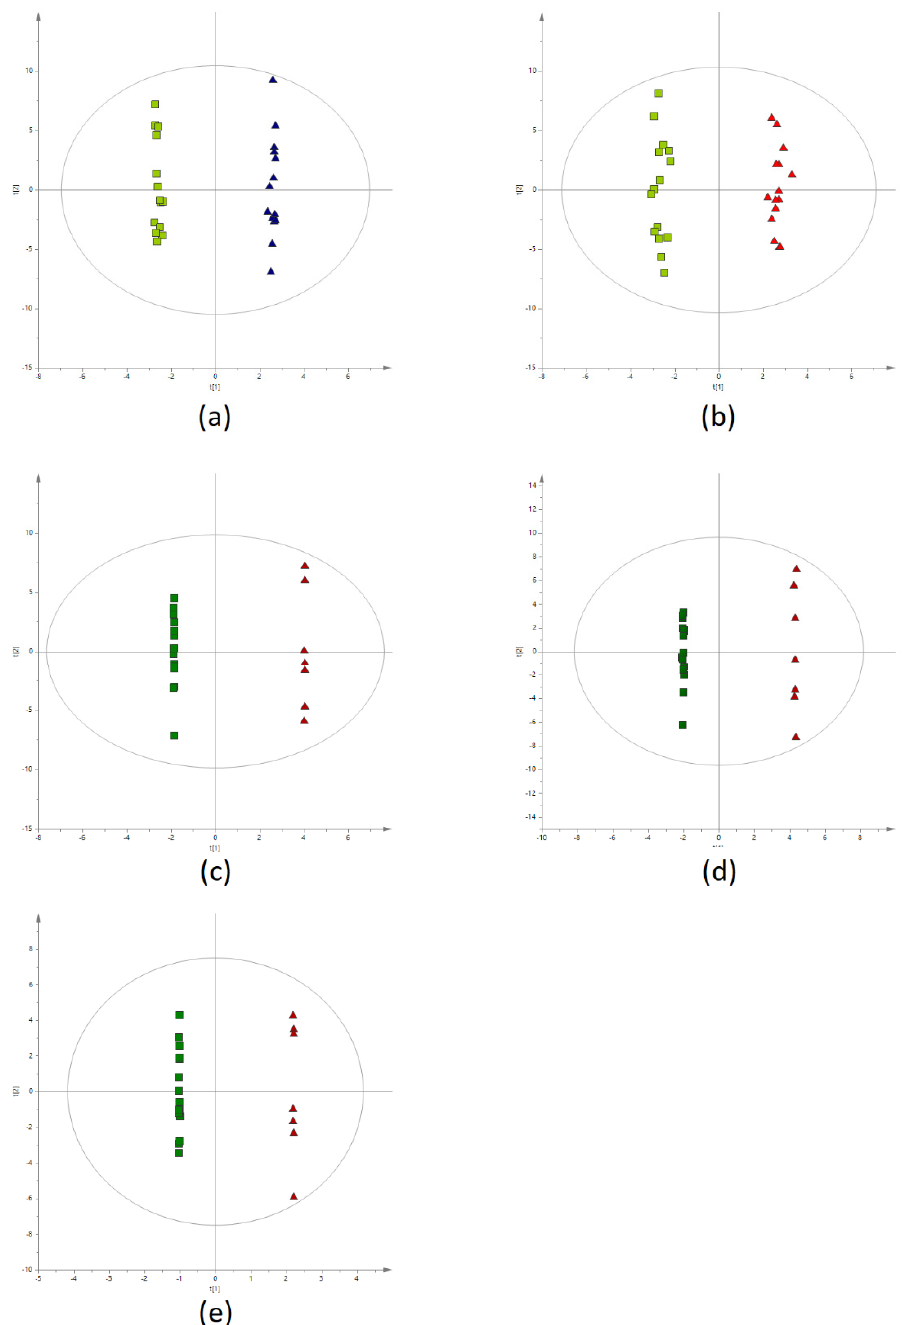
Figure 2. OPLS-DA score plots. ( a ) The classification of BAT(+) samples collected before (green squares) and after 60 min of CE (blue triangles) (negative ion mode, R 2 = 0.998, Q 2 = 0.472). ( b ) The classification of BAT(+) samples collected before (green squares) and after 120 min of CE (red triangles) (negative ion mode, R 2 = 0.991, Q 2 = 0.505). ( c ) The discrimination of BAT(+) (green squares) and BAT( − ) (red triangles) samples collected after 60 min of CE (negative ion mode, R 2 = 1, Q 2 = 0.568). ( d ) The discrimination of BAT(+) (green squares) and BAT( − ) (red triangles) samples collected after 120 min of CE (negative ion mode, R 2 = 1, Q 2 = 0.542). ( e ) The discrimination of BAT(+) (green squares) and BAT( − ) (red triangles) samples collected after 120 min of CE (positive ion mode, R 2 = 1, Q 2 = 0.609).